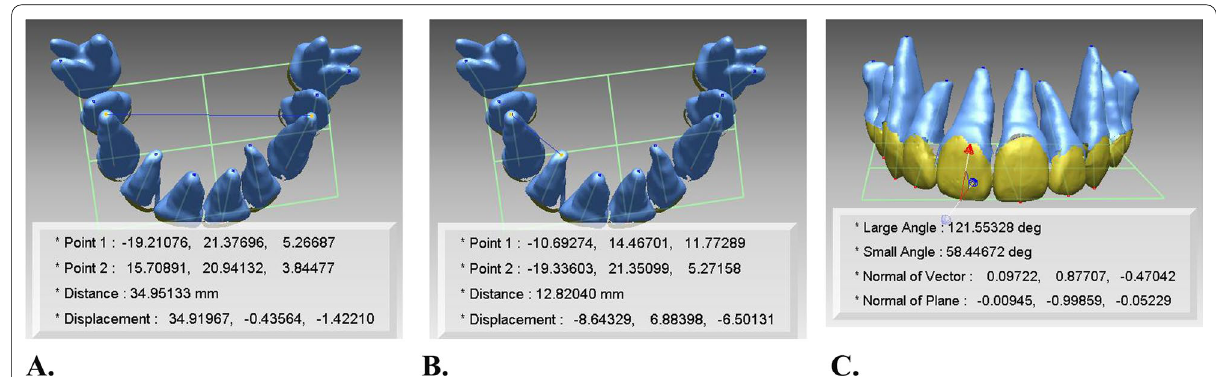
Fig. 3 Measurements used for evaluation of integration accuracy. a and b 3D Euclidean arch width and inter‑root distances in each estimated and actual tooth models; c root axis angle to occlusal plane in each estimated and actual tooth